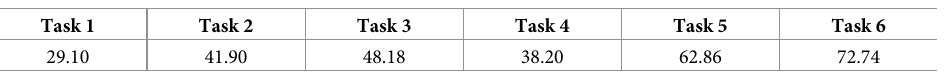
Table 4. Contrast-to-noise